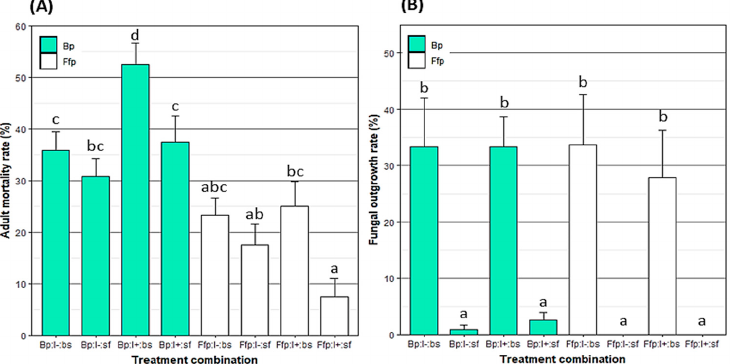
Figure 1. Mean ± SE of ( A ) mortality rate (%) of Myzus persicae eight days after exposure to a spray of B. bassiana and/or release on B. bassiana -inoculated plants and ( B ) fungal outgrowth rate (%) from M. persicae cadavers after ten days of incubation. Treatments were based on combinations